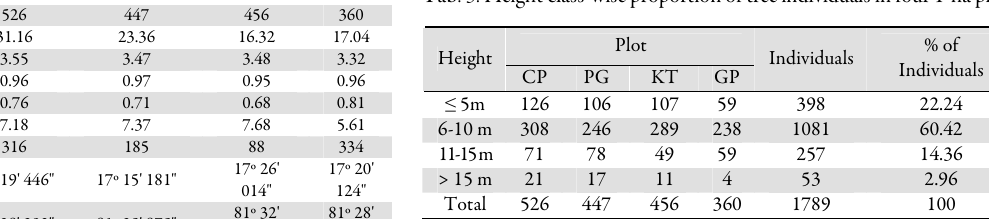
Tab. 3. Height class-wise proportion of tree individuals in four 1-ha